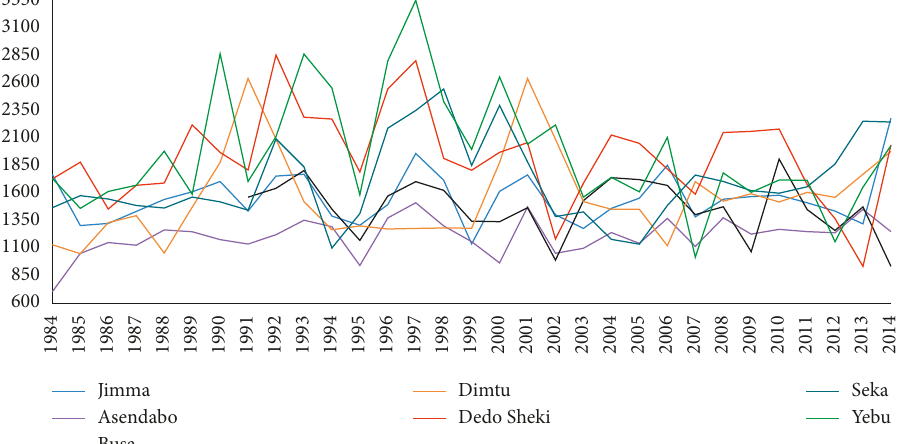
Figure 2: Time series of annual rainfall in mm at seven stations in/around Gilgel Gibe river